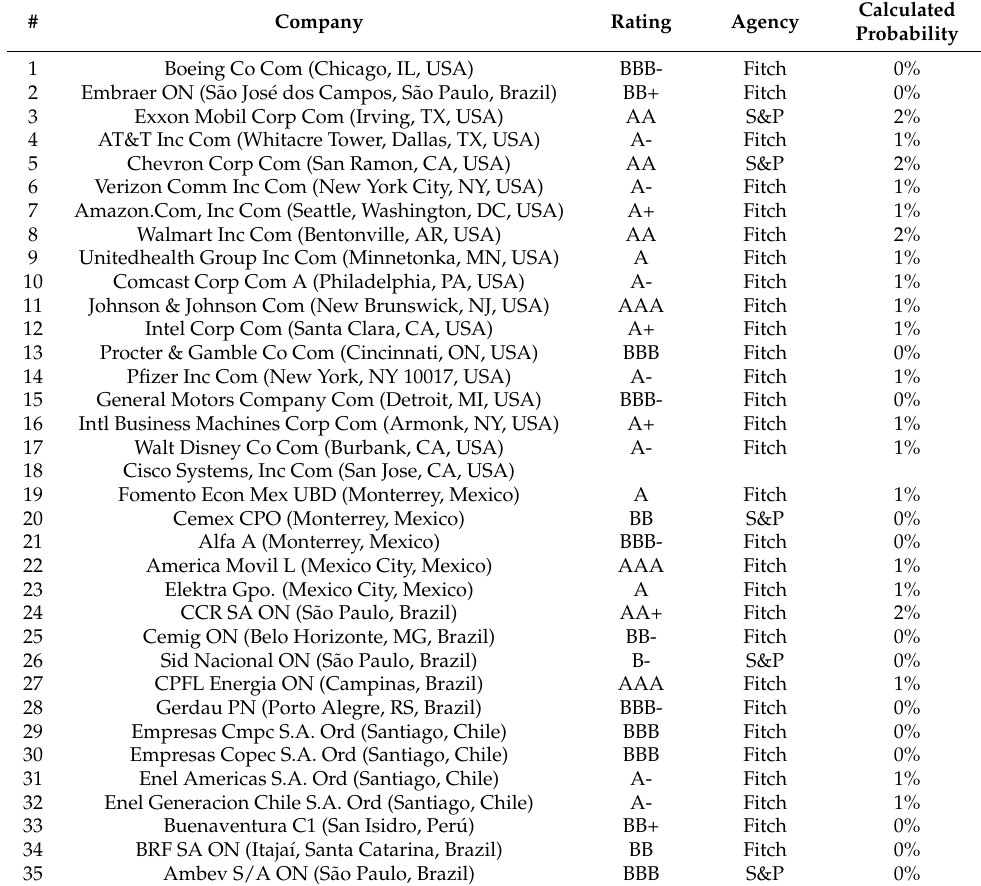
Table 2. Average default probabilities compared to agency